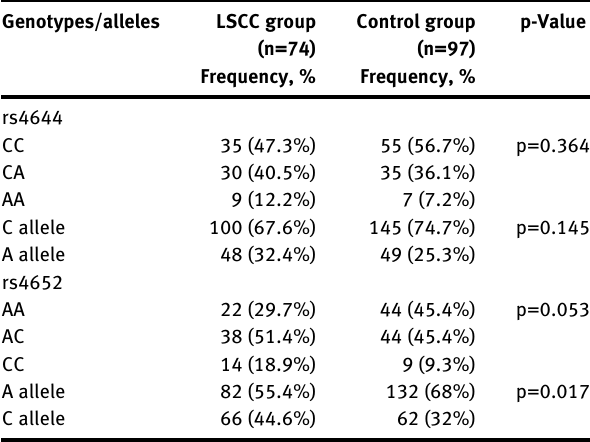
Table  : LGALS  allele and genotype distribution in study groups.